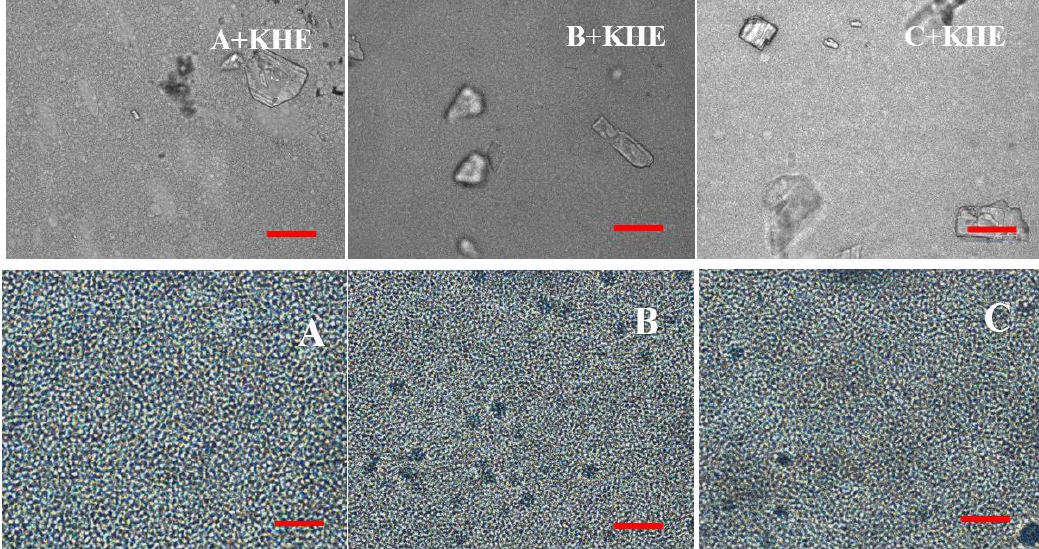
Figure 3. Micrographs of gel-in-oil emulsions A, B and C and of KHE-containing oil-in-gel emulsions (A+KHE, B+KHE, C+KHE) in bright light (Scale bar = 40 μm) . Table 3. Oil-in-gel emulsion s’ droplet size distribution (mean ± SD; n = 3).